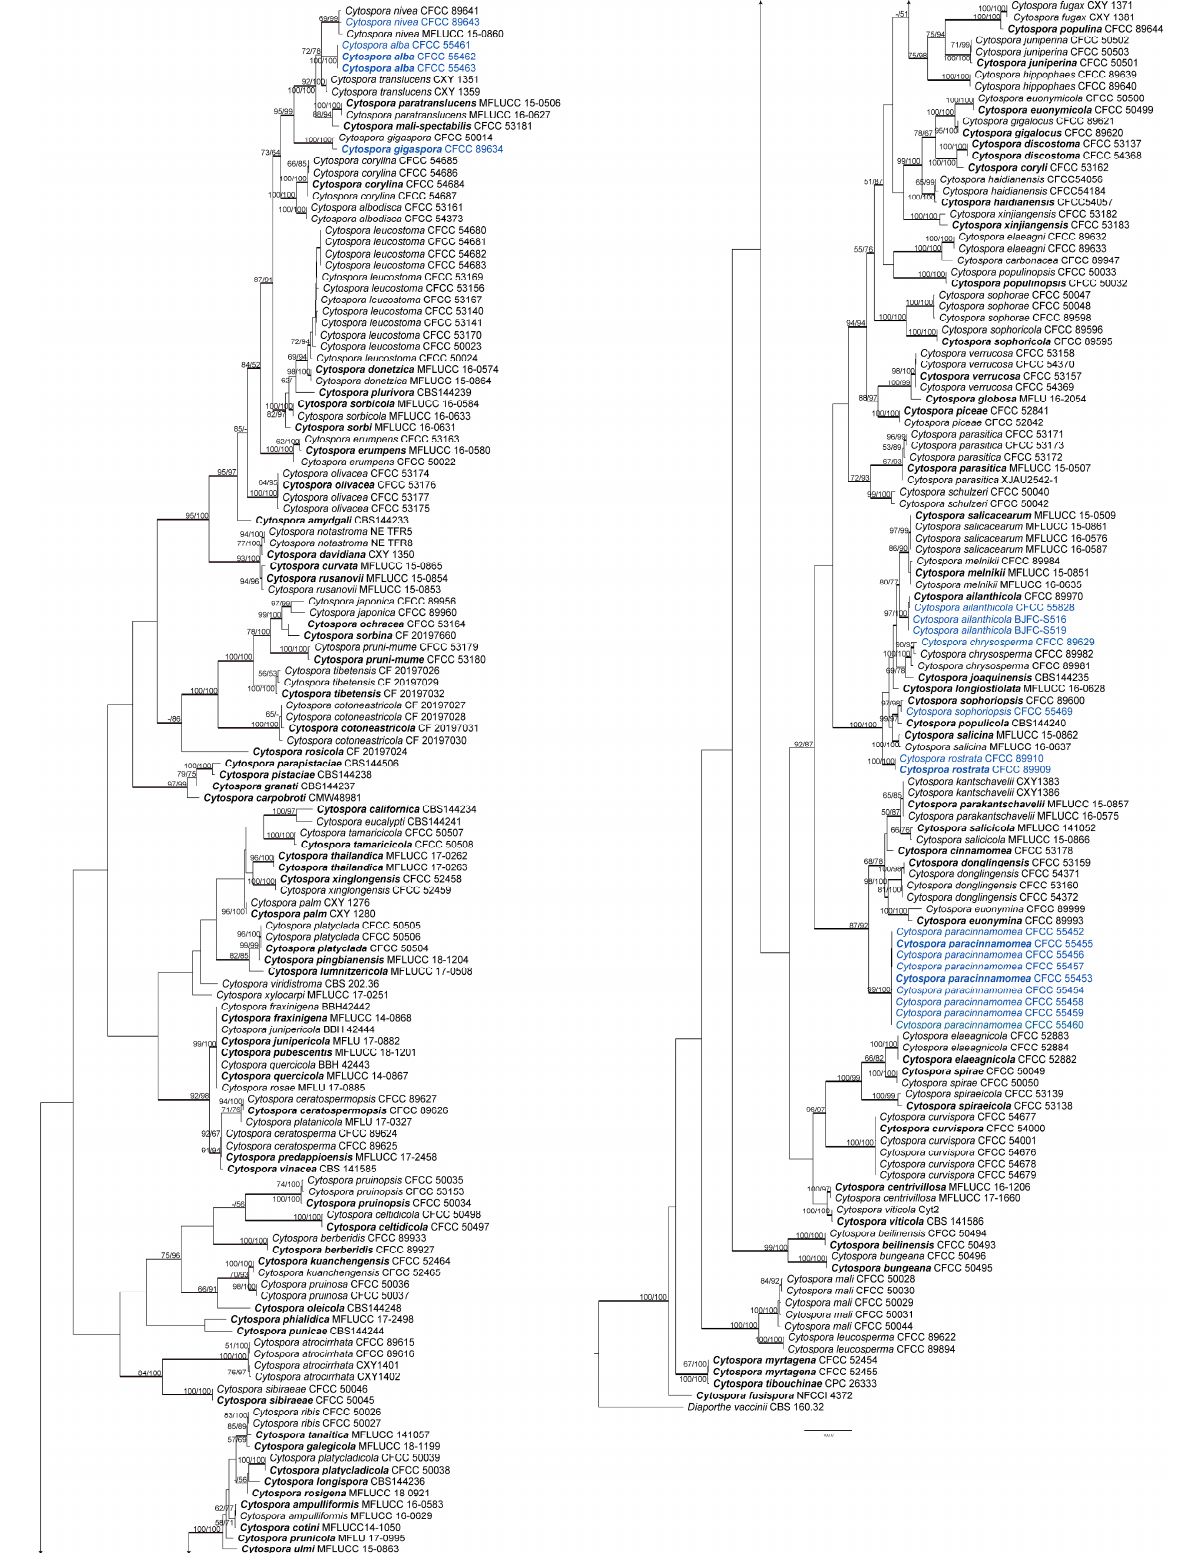
Figure 2. Maximum parsimony phylogram of Cytospora based on combined ITS, act , rpb2 , tef1- α , and tub2 genes. MP and ML bootstrap support values above 50% are shown at the first and second position. Thickened branches represent posterior probabilities above 0.95 from BI. Ex-type strains are in bold. Strains from the current study are in